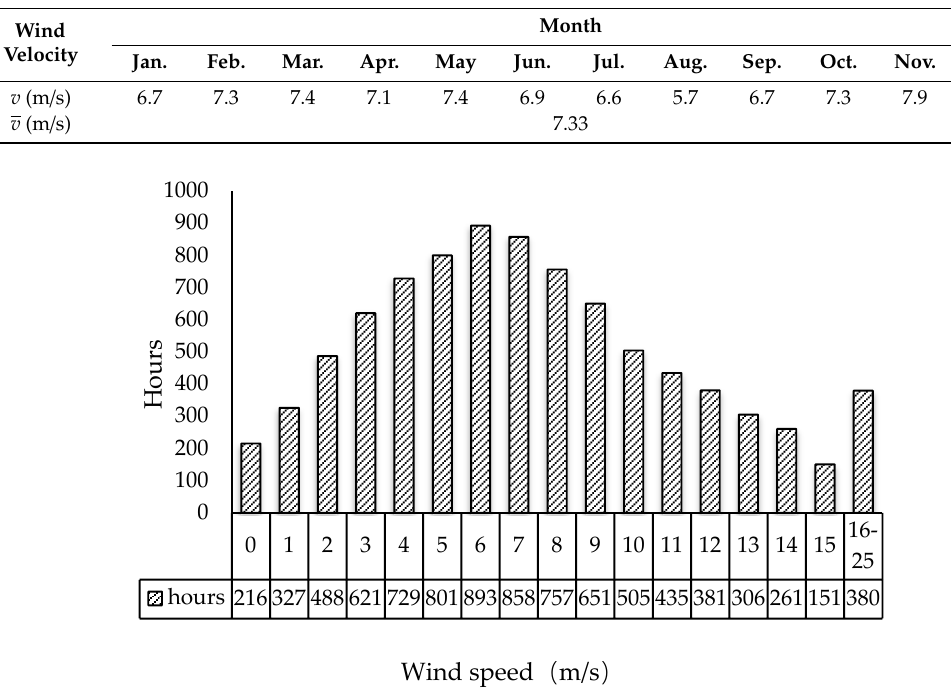
Table 4. Average monthly wind velocity.